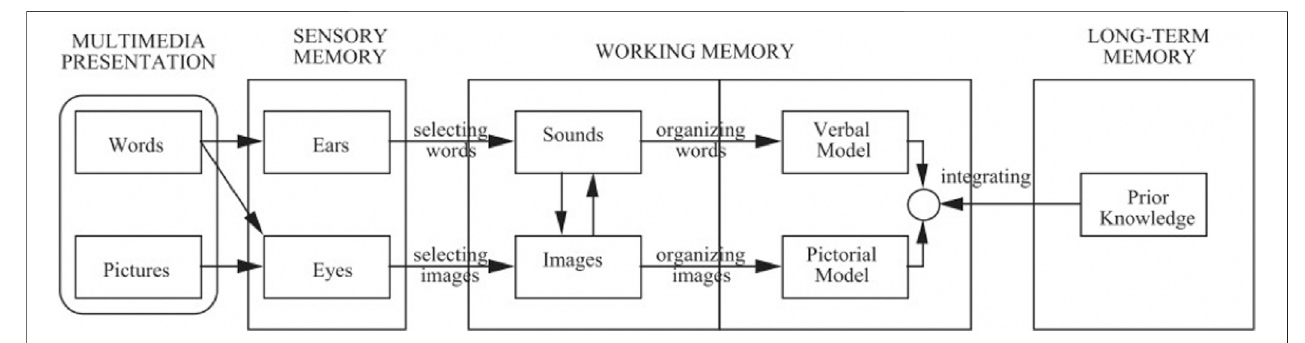
FIGURE 2 | Mayer ’ s cognitive theory of multimedia